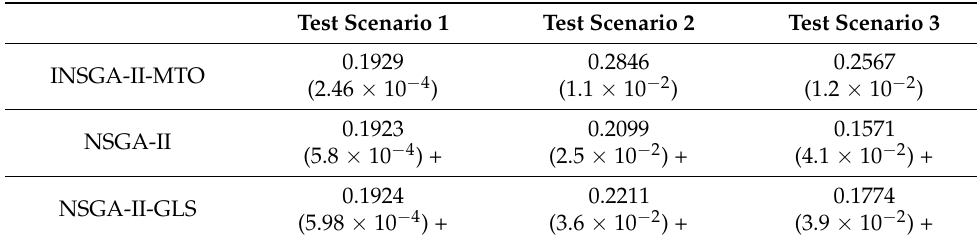
Table 2. HV results of all comparison algorithms in three scenarios.